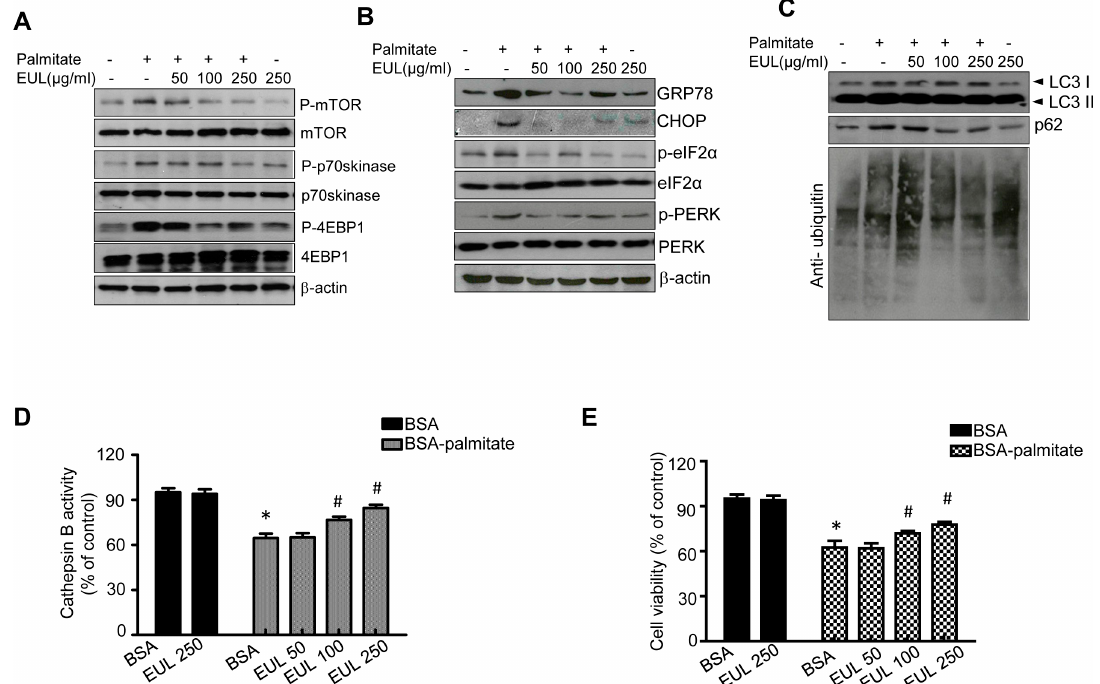
Figure 7. Effects of EUL on ER stress and lysosomal function in HepG2 cells. HepG2 cells were treated with 50 µ g/mL, 100 µ g/mL, or 250 µ g/mL EUL for the indicated periods, and the expression of proteins of interest was determined by western blotting. ( A ) Immunoblotting using antibodies against p-mTOR, mTOR, p-p70S6K, p70S6K, p-4EBP-1, 4EBP-1, and β -actin. ( B ) Immunoblotting using antibodies against GRP78, CHOP, p-PERK, PERK, p-eIF2 α , eIF2 α , and β -actin. ( C ) Immunoblotting using antibodies against LC-3, p62, ubiquitin, and β -actin. ( D ) HepG2 cells were incubated with the indicated concentrations of EUL for 24 h, and cathepsin B activity was determined. ( E ) HepG2 cells were treated with 50 µ g/mL, 100 µ g/mL, or 250 µ g/mL EUL for the indicated periods, and cytotoxicity was determined using the MTT assay. Values are means ± SDs. n = 3, * p < 0.05 versus control. # p < 0.05 versus palmitate. EUL, Eucommia ulmoides leaf extract, BSA; bovine serum albumin.